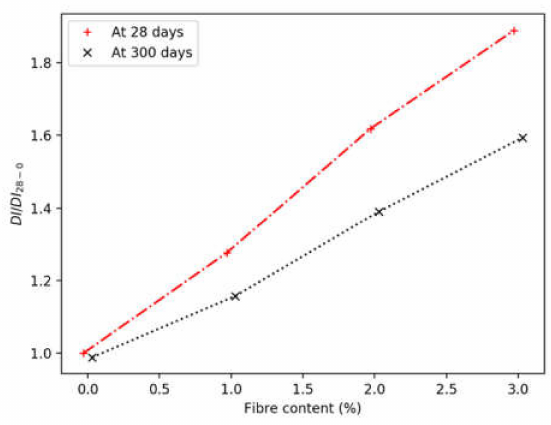
Figure 9. Normalised ductility indices at various fibre contents ( DI 28-0 : DI of the plain mortar specimen at 28